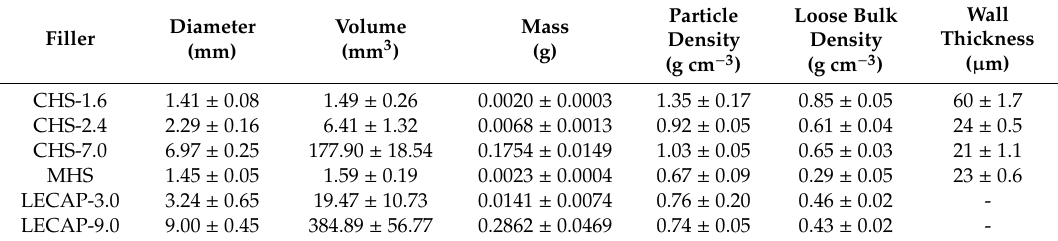
Table 3. Diameter, volume, mass, density and wall thickness values of the filler materials.